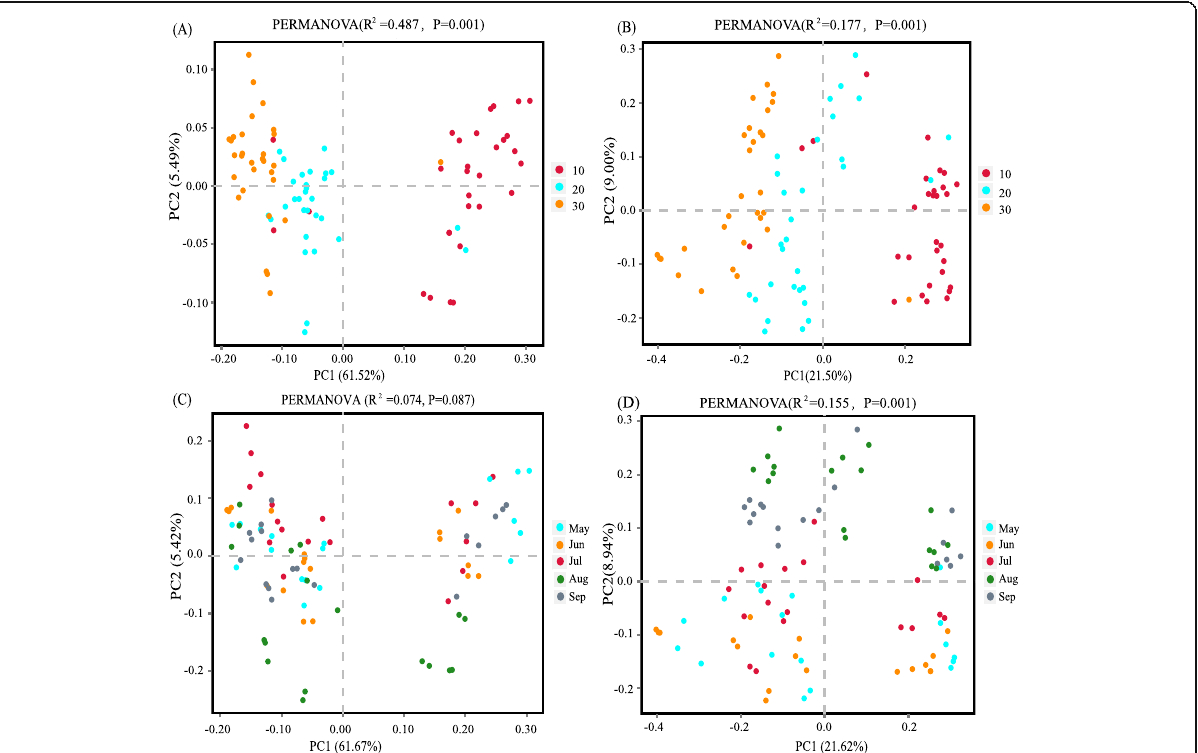
Fig. 1 PCoA analysis of soil microbial community structure based on Bray-Curtis distance algorithm. a , b represent bacteria and fungi at different soil depths, and c , d represent bacteria and fungi in different month. Dots represent each sample; colors represent different groupings. The horizontal and vertical coordinates are values that cause the largest difference between samples, and reflect the influence as a percentage.10, 20, and30 represent 10 cm, 20 cm, and 30 cm of soil depth, respectively. May, Jun, Jul, Aug, and Sep represent the soil sampled in May, June, July, August, and September, respectively. The larger the R 2 -value, the higher the interpretation degree of the grouping to the difference, and the greater the grouping difference. When the p < 0.05, the reliability of the test is